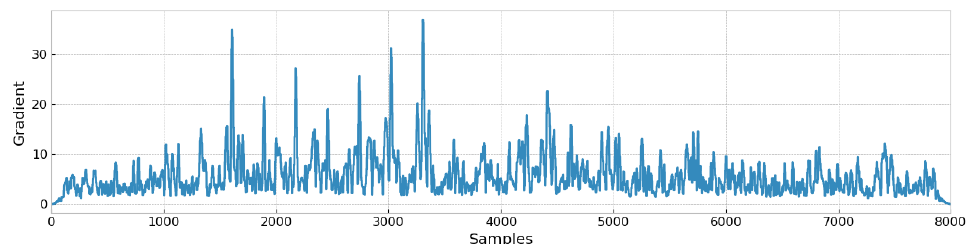
Figure 11: Input gradient visualization for the cswap-arith dataset.